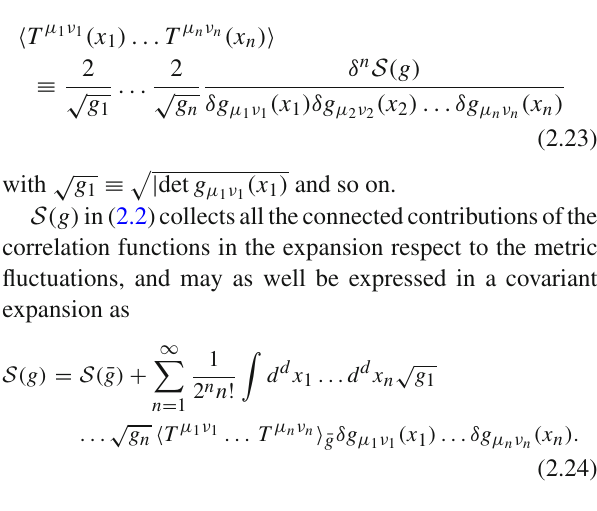
Diagrammatically, for a scalar theory in a flat background,